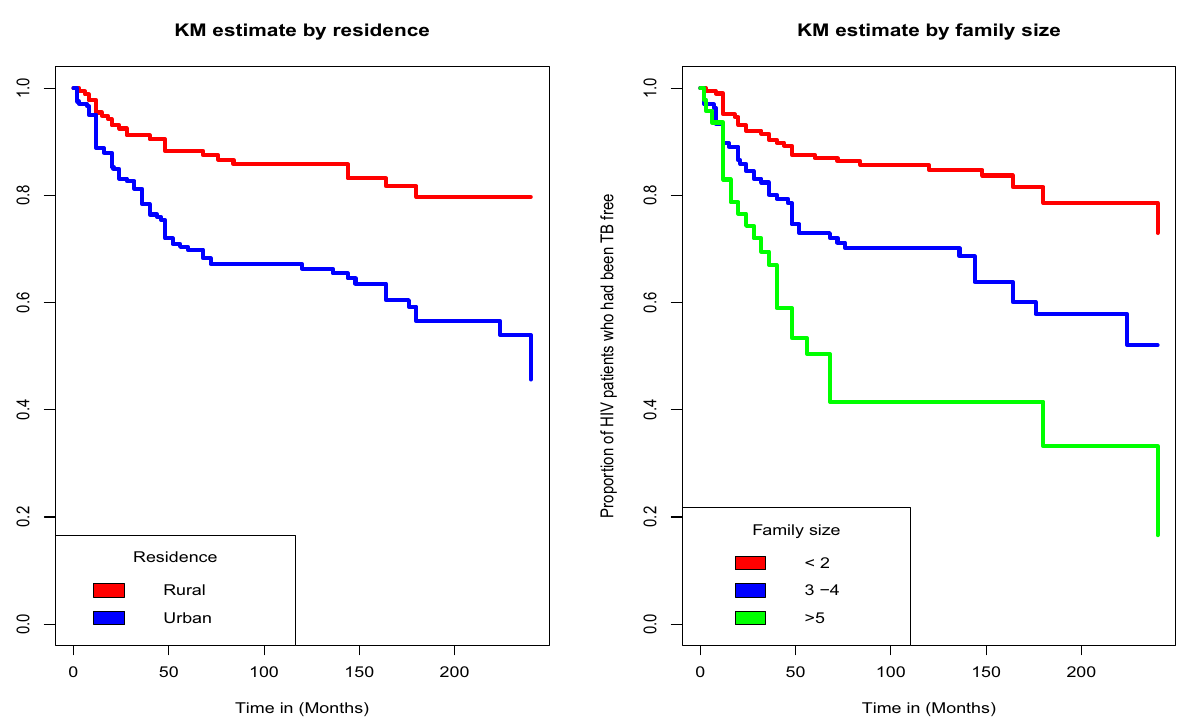
Figure 2. Kaplan-Meier survival curves for TB free co-infection survival time of patents by residence of patients and family size of Comparison of Bayesian parametric survival models. Parametric AFT survival models(Exponential, WAIC and Marginal likelihood of the models were used. The model with the smallest values of DIC and WAIC, and largest value marginal log-likelihood is selected as the best model. The five parametric survival models with their corresponding values of DIC, WAIC and Marginal LIkelihood values are displayed in Table 2. The Bayesian Log-logistic AFT model was found to be the best fitting model for our data set as it has the smallest values of DIC and WAIC, and has the largest values of marginal loglikelihood among the five models .